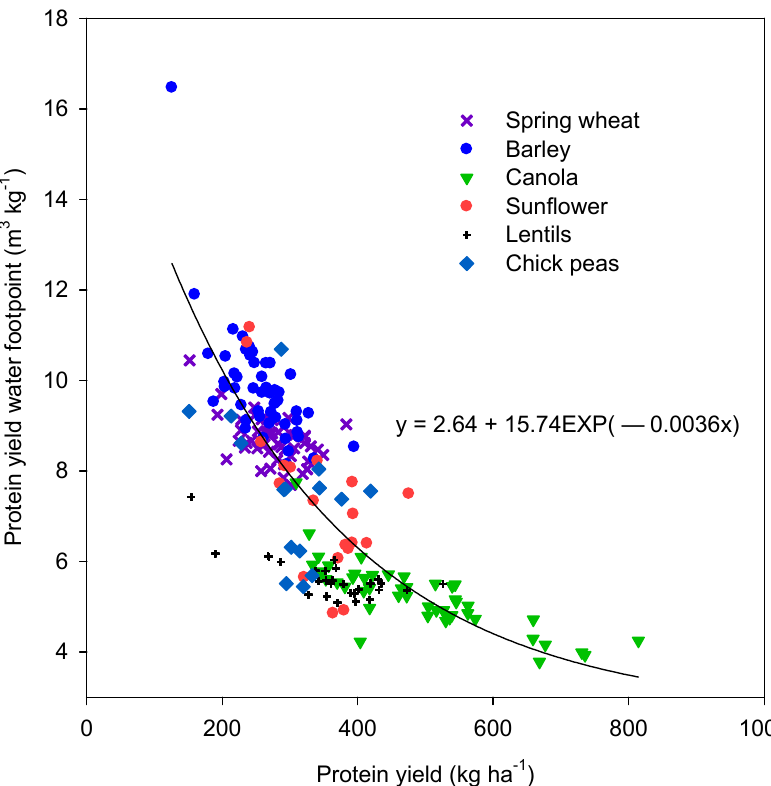
Figure 10. Relationship between crop protein yield-based water footprints (WFs) and protein yields in Saskatchewan.